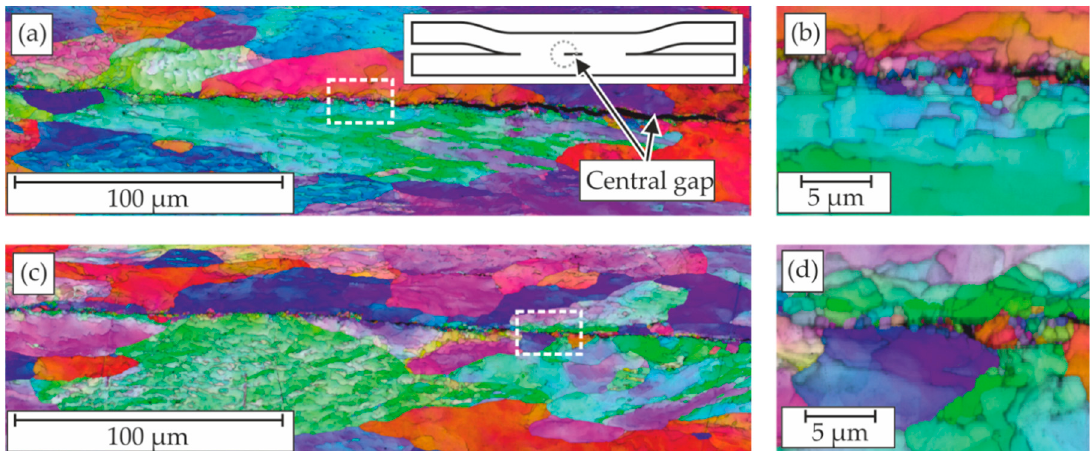
Figure 9. Combined inverse pole figure (IPF) and image quality (IQ) maps of the interface region obtained at constant impact velocity v imp ≈ 243 m/s at ( a , b ) 100,000 Pa and ( c , d ) 100 Pa ambient pressure: the inset in ( a ) shows the sample positions where the maps were obtained using EBSD measurements. The white outlines in ( a , c ) mark the positions of the detailed maps in ( b , d ). Welding direction to the left from the central initial collision point.